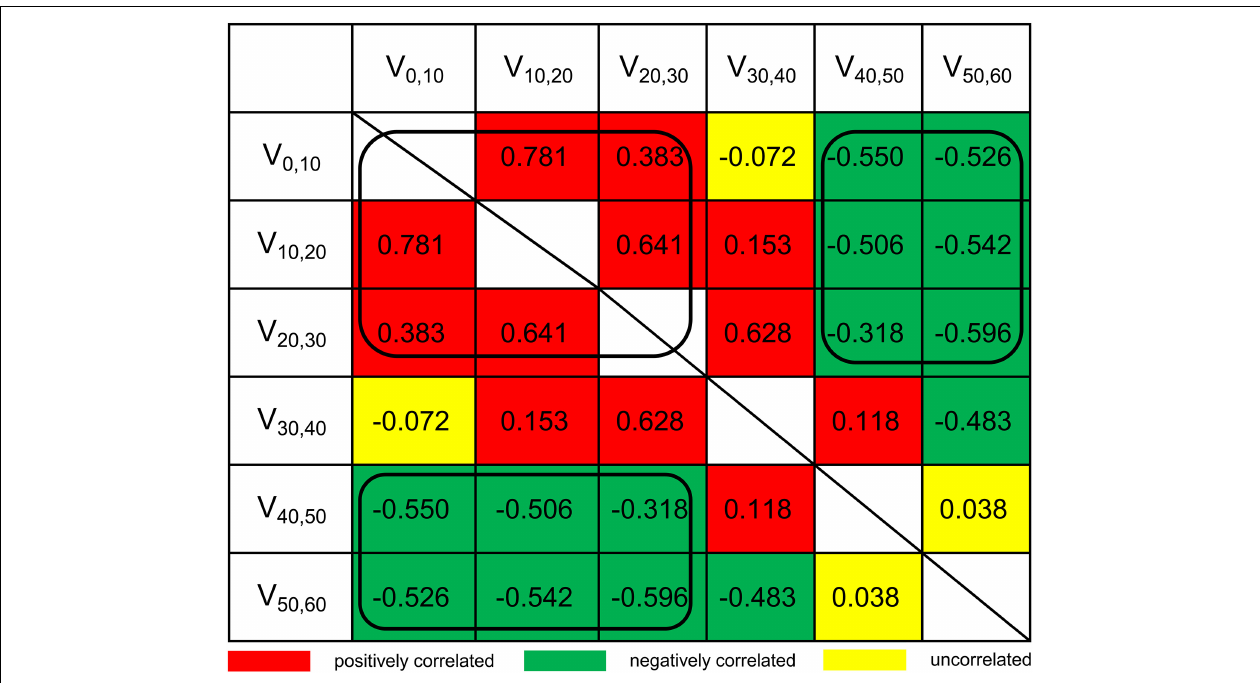
FIGURE 2 | Pairwise Spearman correlation coefficients between dosimetry parameters. V a , b , the percentage of thyroid volume receiving irradiation doses of a–b Gy. TABLE 3 | Different logistic regression models and their area under the